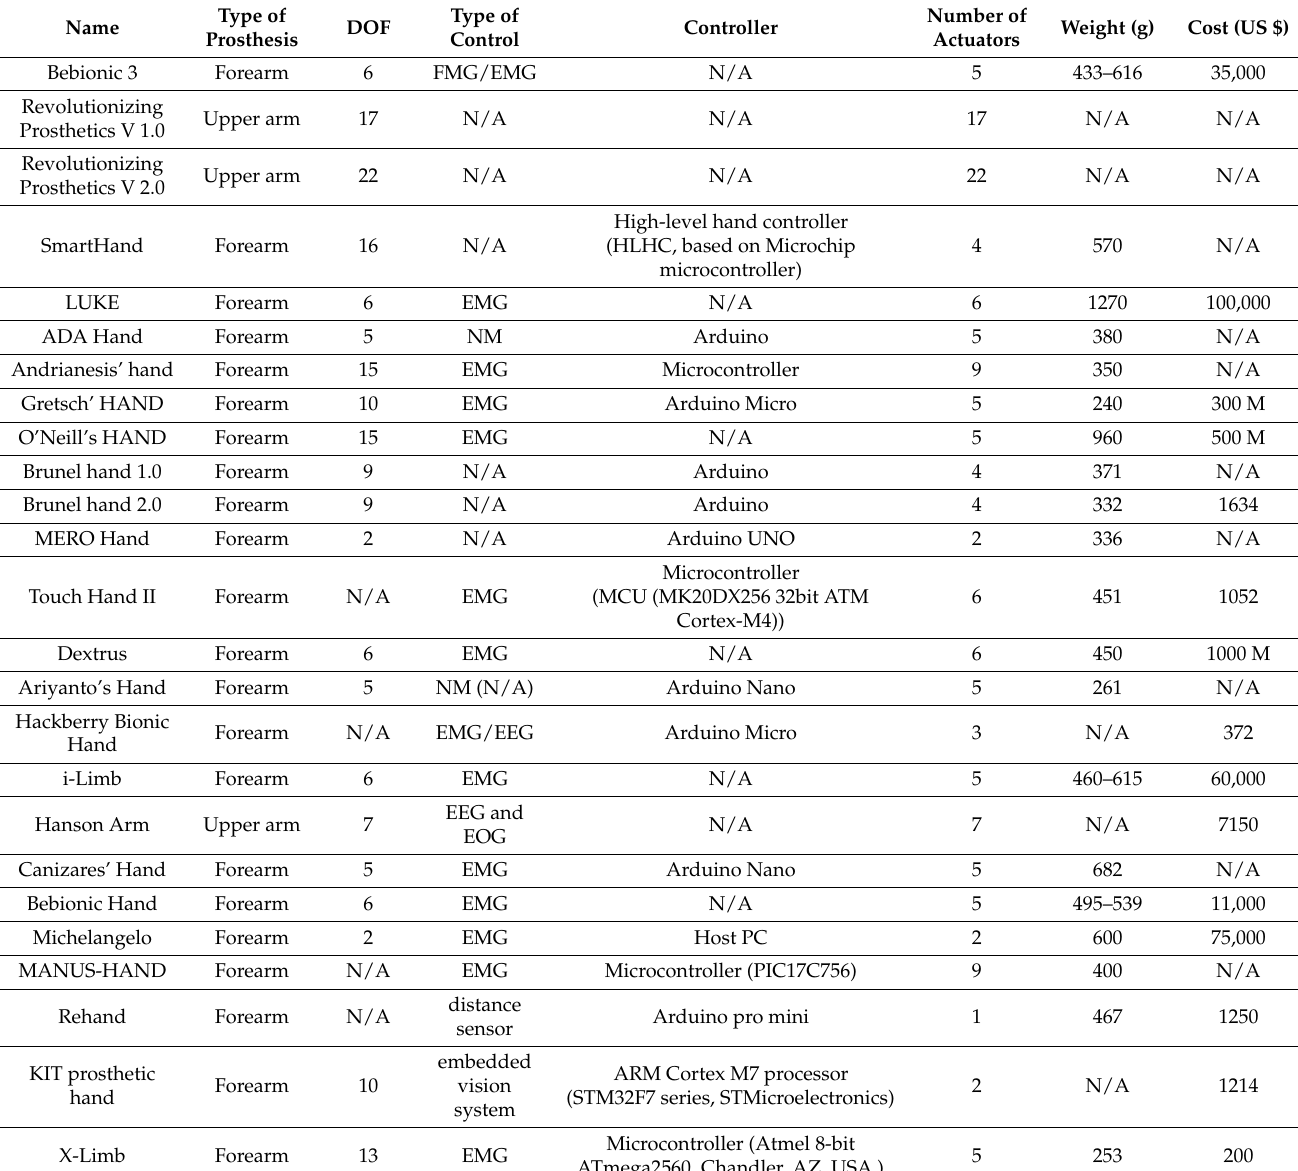
Table 1. Specification of prosthetic